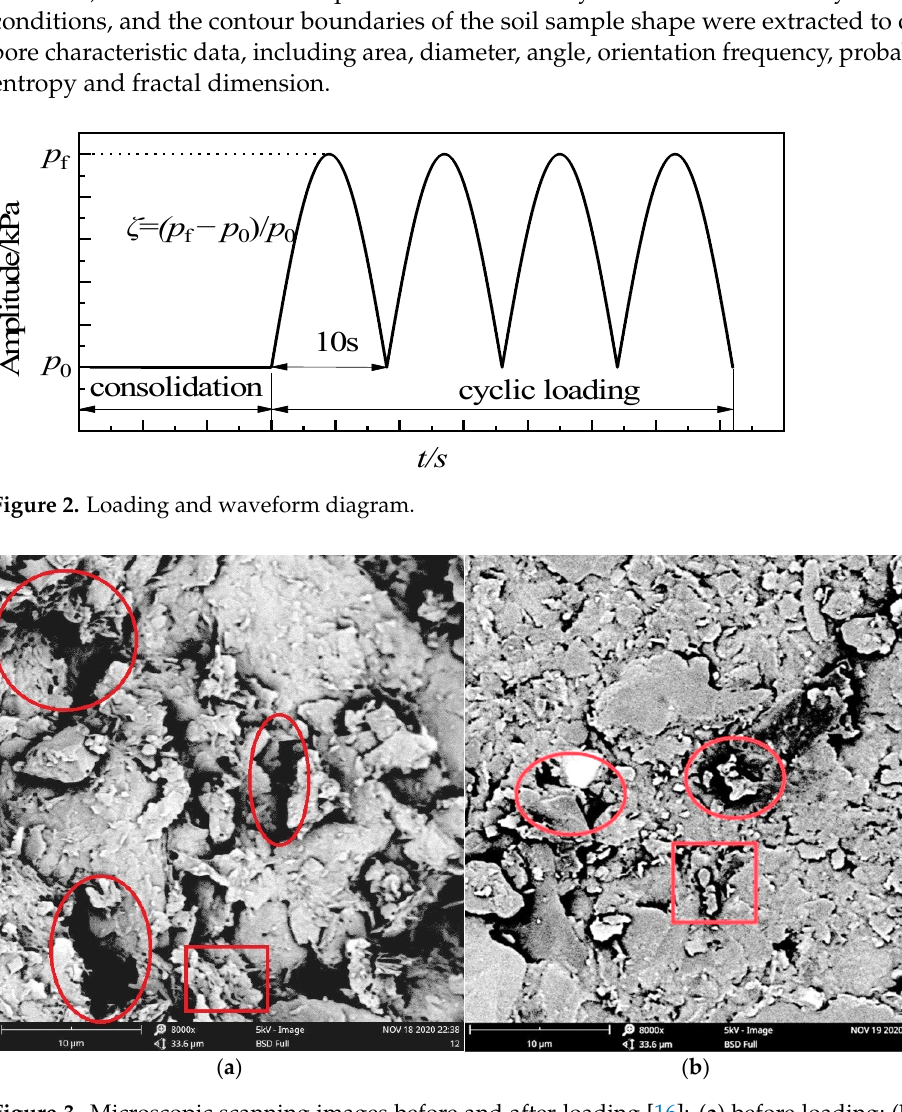
Figure 2. Loading and waveform diagram.